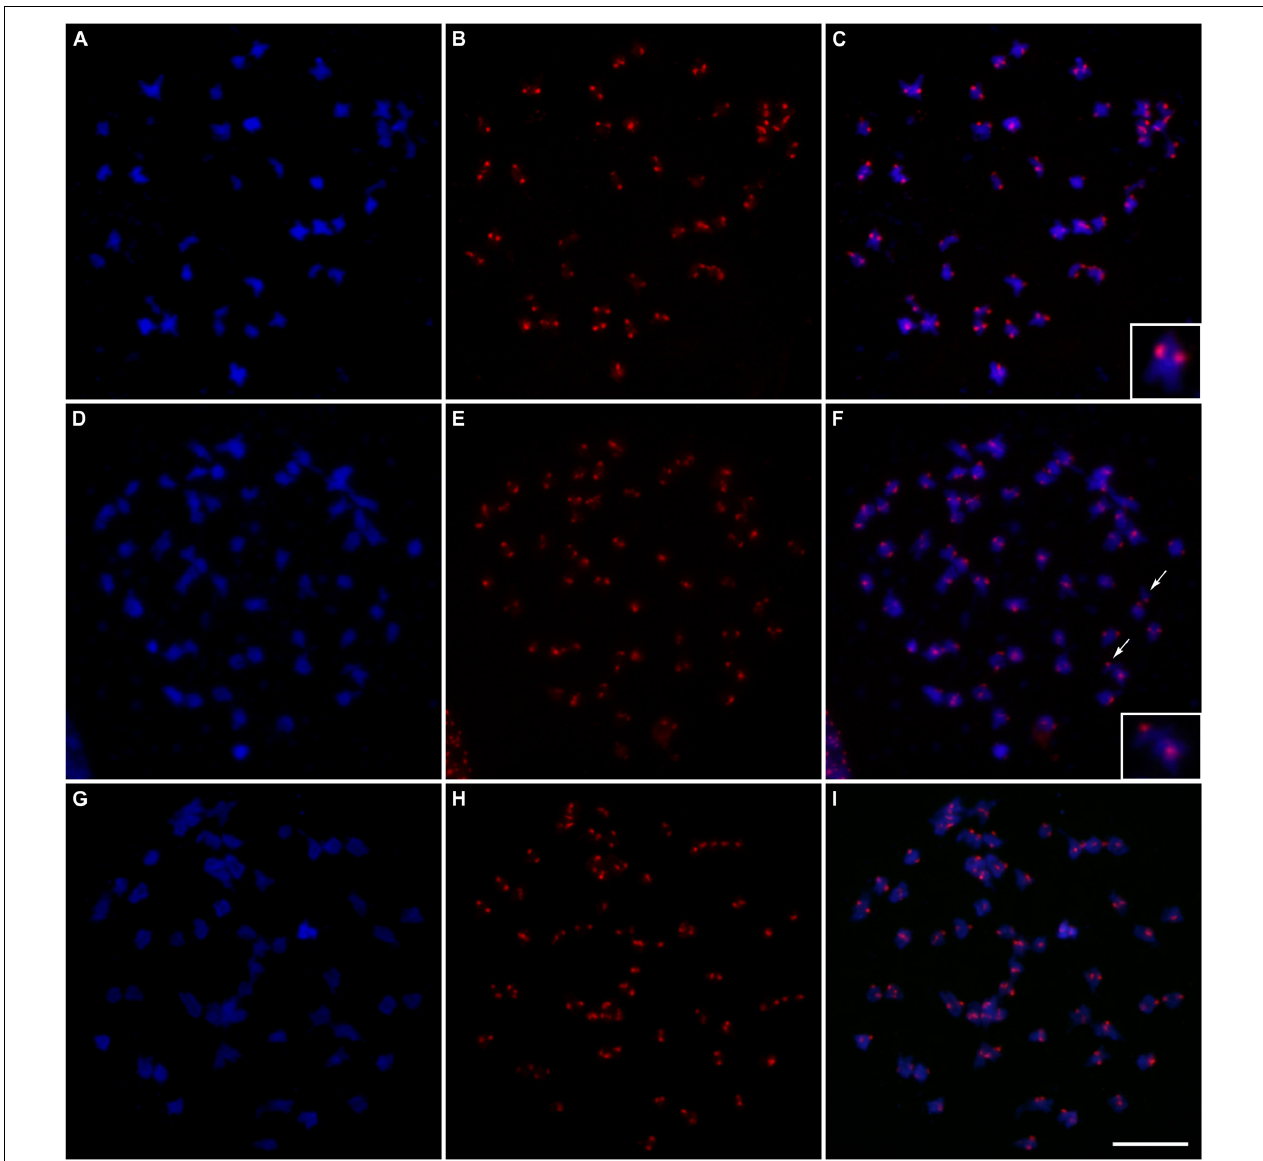
FIGURE 5 | Fluorescent in situ hybridization of centromeric probes on meiotic cells at diakinesis: (A) Chromosomes of “Caiana Fita” ( Saccharum officinarum ) stained with DAPI (blue); (B) Centromeric sites hybridized with the CENT probe detected with anti-DIG-rhodamine (red); (C) Superposition of the images (A/B) showing 40 bivalents; the inset shows a typical bivalent; (D,G) Chromosomes of “IACSP93-3046 stained with DAPI (blue); (E,H) Centromeric sites hybridized with the CENT probe detected with anti-DIG-rhodamine (red); (F) Superposition of the images (D/E) showing 56 bivalents plus two univalents; arrows point to the univalents and the inset shows a univalent and a bivalent; (I) Superposition of the images (G/H) showing 56 bivalents. Bar, 10 µ m.